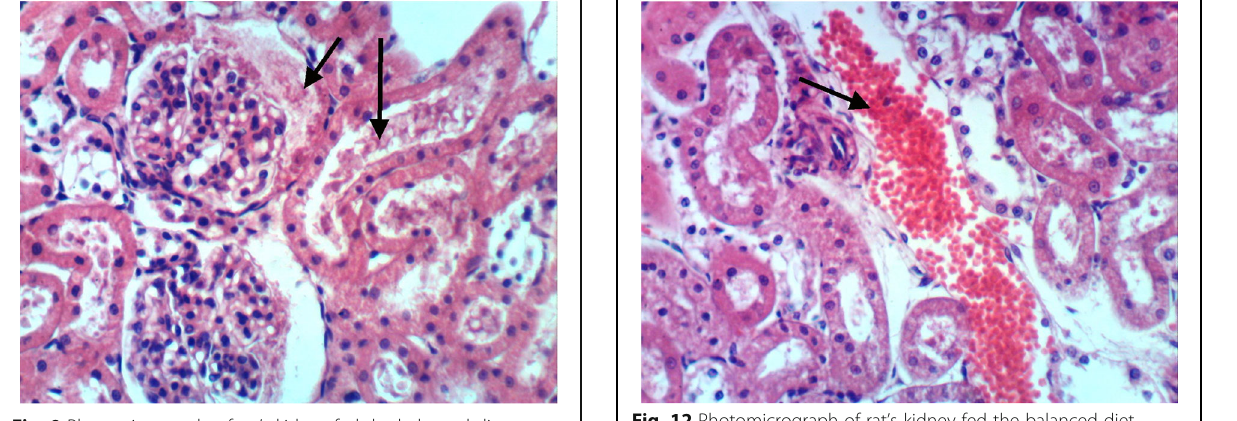
Fig. 9 Photomicrograph. of rat ’ s kidney fed the balanced diet supplemented with taurine+pot.bromate,showing hypercellularity of glomerular tuft (H&E × 400)